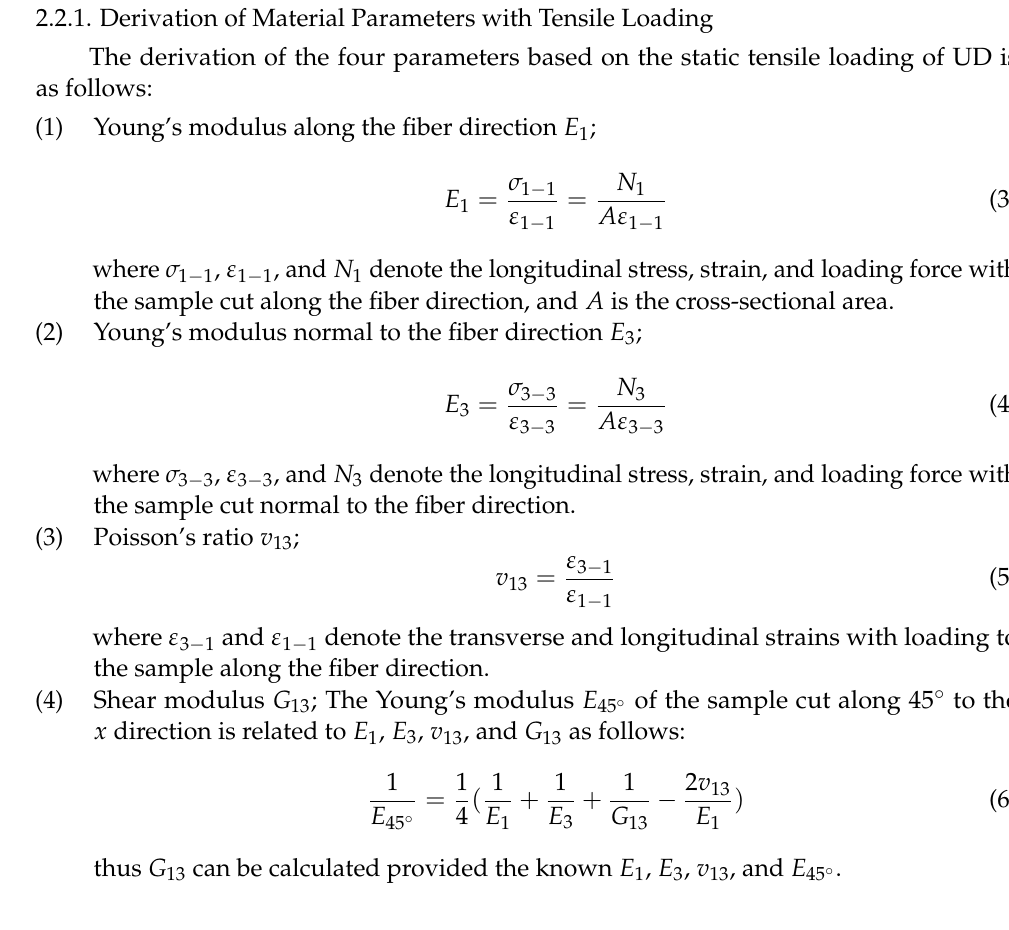
Figure 3. Experimental setup of GW testing. Table 3. Parameters of GW testing.